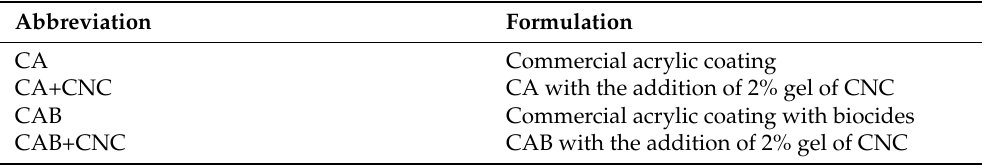
Table 1. Formulations and abbreviations of the coatings used in the